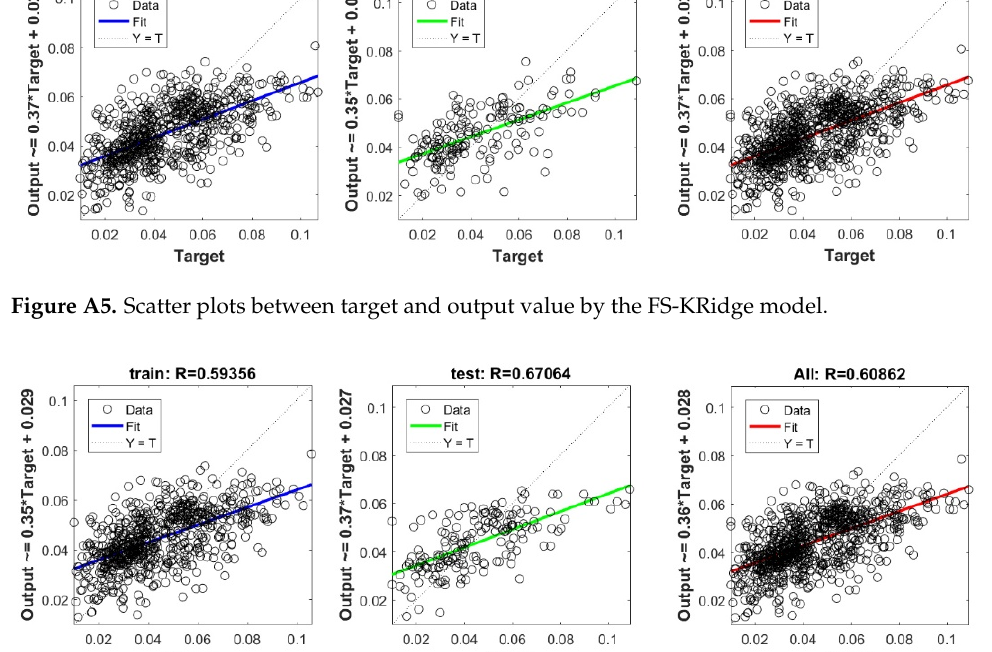
Figure A6. Scatter plots between target and output value by the FS-lasso model.